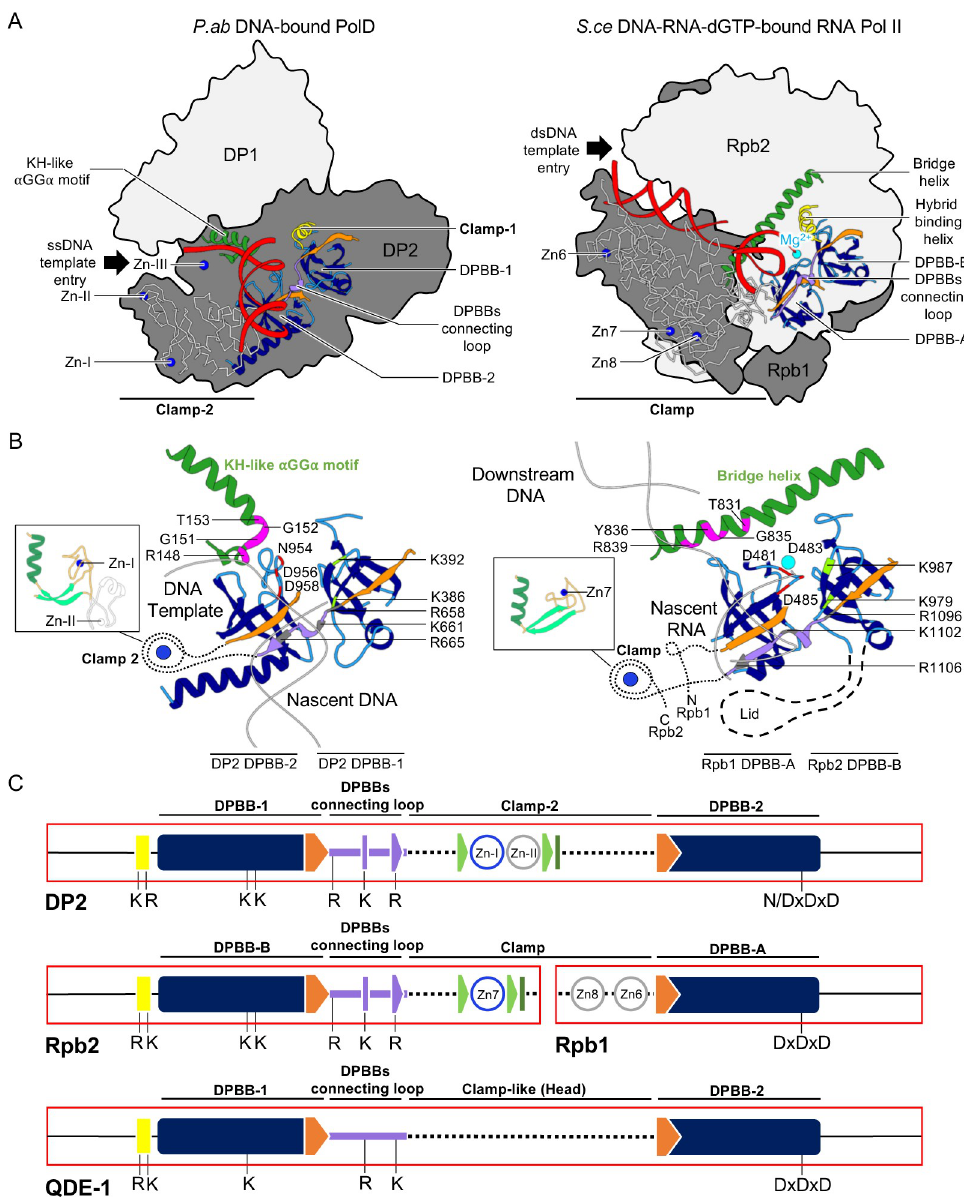
Fig 9. Structure-based comparison of PolD and two-DPBB RNAPs. (A) Shared structural elements between P . abyssi (“P.ab”) PolD and S . cerevisiae (“S.ce”) RNAP-II (PDB ID: 2E2I [25]). The structures of PolD and RNAP-II are aligned with respect to their two-DPBB catalytic core. Black arrows indicate the DNA template entry site in both PolD and RNAP-II active sites. DPBBs are colored in blue, with the last β strand of DPBB-1 (or DPBB-B) and the first β strand of DPBB-2 (or DPBB-A) colored orange. The conserved DPBB-connecting loop (purple) and template-binding helix (yellow) are also shown. The clamp-2 domain of PolD and the clamp domain of RNAP-II are depicted with a white backbone trace. The conserved α GG α motif of the PolD KH-like domain and the bridge helix of RNAP-II occupy the same location with respect to the nascent duplex. Zn-binding domains and Mg 2+ ions are depicted with blue and cyan spheres, respectively. (B) Enlarged view of the shared structural elements between PolD and RNAP-II. (C) Genetic organization of these shared structural elements in PolD, DNA-dependent RNAPs, and QDE-1. dGTP, deoxyguanosine triphosphate; DPBB, double-psi β -barrel; dsDNA, double-stranded DNA; KH, K-homology; QDE-1, quelling defective phenotype; RNAP, RNA polymerase; ssDNA, single-stranded DNA.